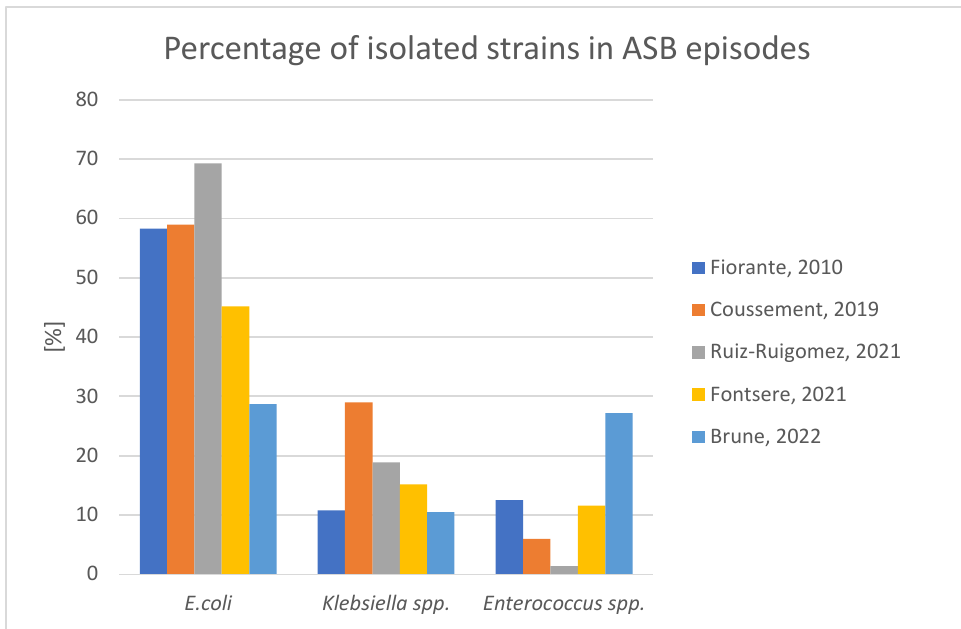
Figure 1. The most common bacteria isolated in asymptomatic bacteriuria episodes according to various authors.